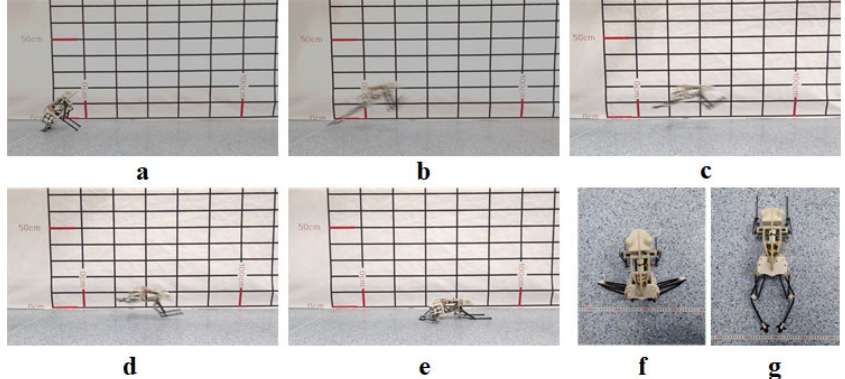
Figure 16. Prototype complete jump process: ( a ): Takeoff preparation; ( b ): Take-off phase; ( c ): Flight phase; ( d ): Landing phase; ( e ) Completely landing; ( f ): Top view before the jump; ( g ): Top view of the limb extension state.